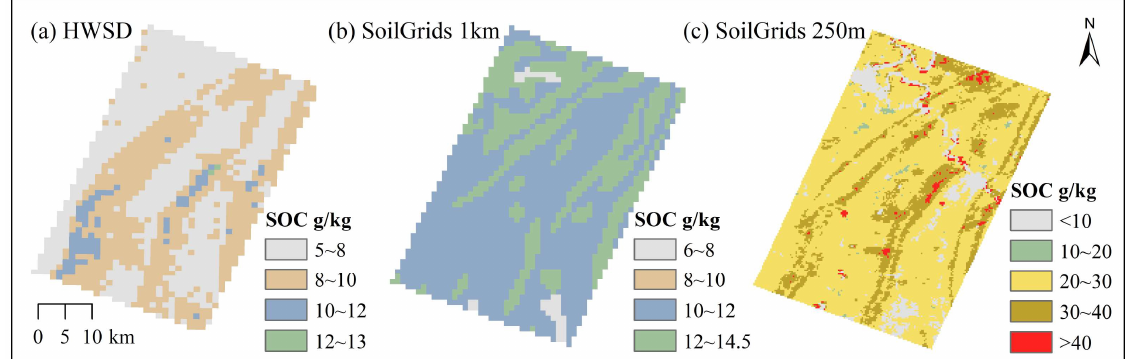
Figure 5. SOC content map by HWSD ( a ), SoilGrids 1 km ( b ) and SoilGrids 250 m ( c ).